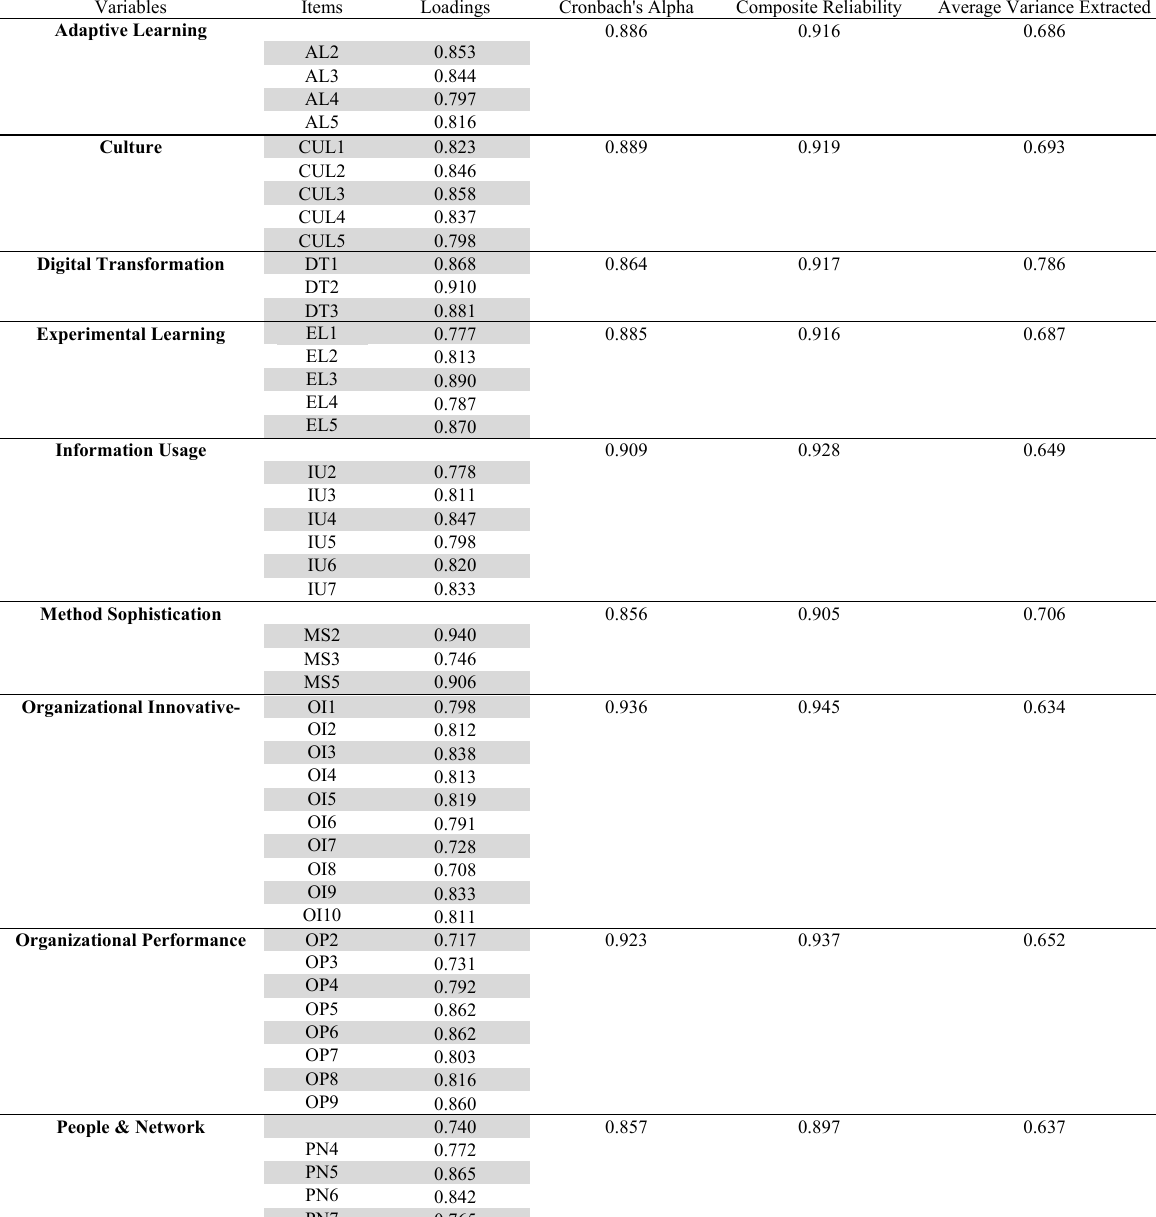
Measurement Model